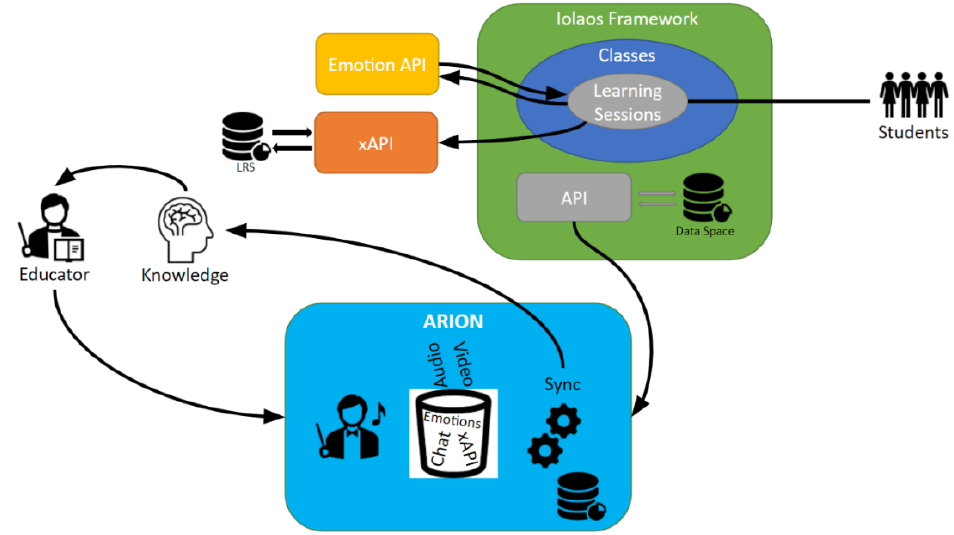
Figure 1. ARION System Overview.